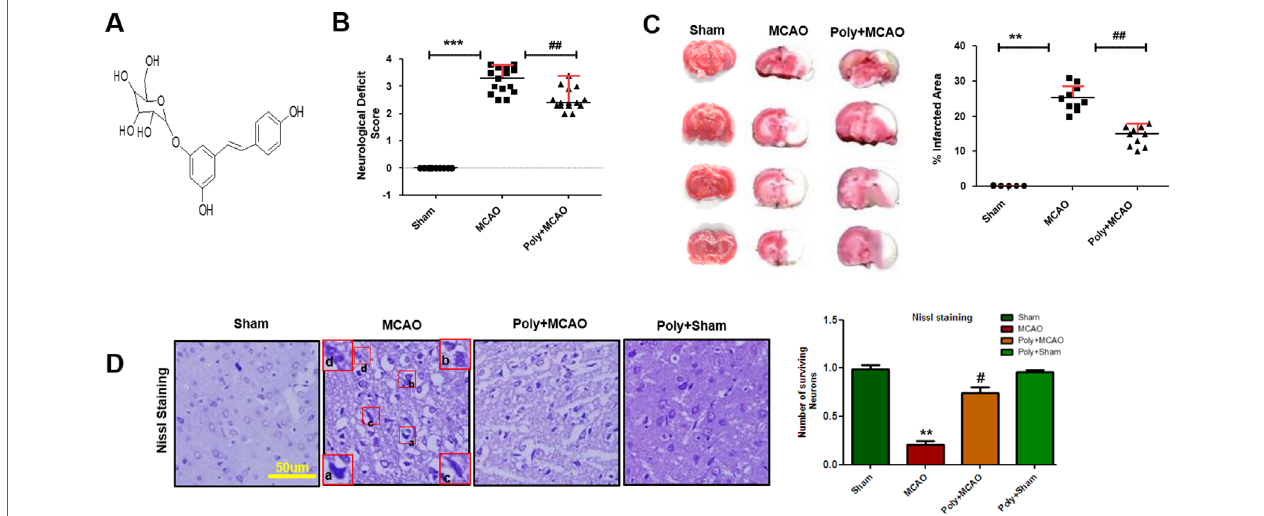
FIGURE 1 | Effect of polydatin on neurological scores, brain infarction and neurodegeneration. (A) Structure of polydatin. (B) Polydatin attenuated neurological deficits. Neurological test was conducted 24 h after ischemia. Poly+MCAO rats had significantly improvement of neurological deficits ( ## p < 0.01) compared to MCAO group. (C) Brain coronal sections were stained with TTC, which distinguishes between ischemic and non-ischemic areas (n = 5–10/group). (D) Representative photomicrograph of cresyl violet staining showing the extent of surviving neurons in the cortex, scale bar = 50 μm. (a, b) Cytoplasmic swelling and scalloped neurons with intense cytoplasmic eosinophilia and nuclear basophilia. These changes result from neuronal ischemia, which impairs metabolism in the tissue. (c) Cytoplasmic fading of neurons, which invariably occurs in neurons at later stages of necrosis (ghost neurons). (d) Some cells had shrunken appearance along with pyknotic nuclei. Intensive neuropil vacuolation can be seen in ischemic cortex (MCAO). *** p < 0.001; **, ## p < 0.01; # p <